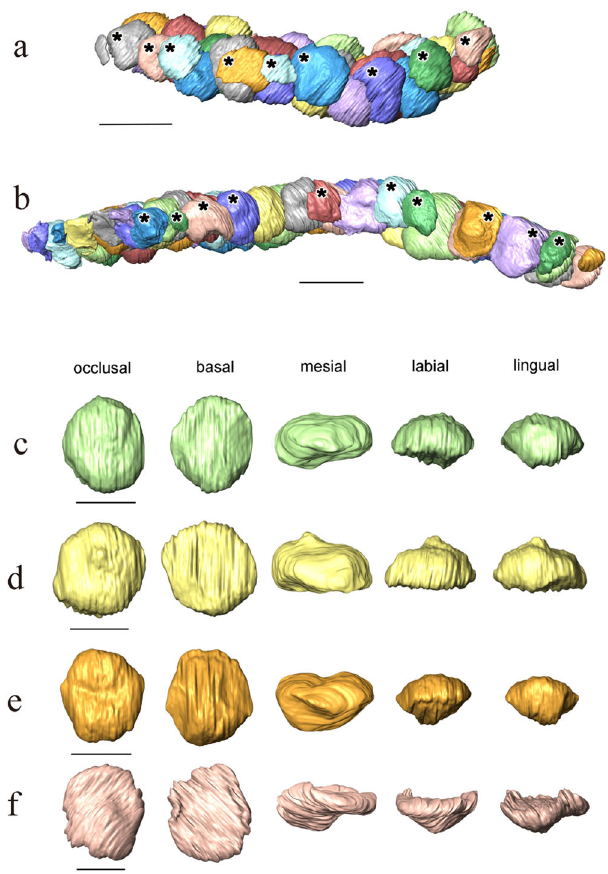
Fig. 6 CT images showing the tooth shape of Sclerocormus cf. S. parviceps (HFUT MJS-16-012). a , b The maxillary and dentary tooth rows, respectively, in occlusal view; functional (surface) teeth are marked with asterisks; note that several functional teeth are heavily worn. c – f Some replacement teeth which exemplify the major morphological features displayed by the dentition. c Typical “ dome shaped ” occlusal surface of a dentary tooth. d The pointed apex on a dentary tooth. e The longitudinal groove on a dentary tooth. f An apico-basally thin replacement cone located posterodorsally in the maxilla, consisting almost entirely of enamel; note the irregular margin and reduced root. The scale bars for the tooth rows are 1 cm and the scale bars for each tooth are 5 mm.